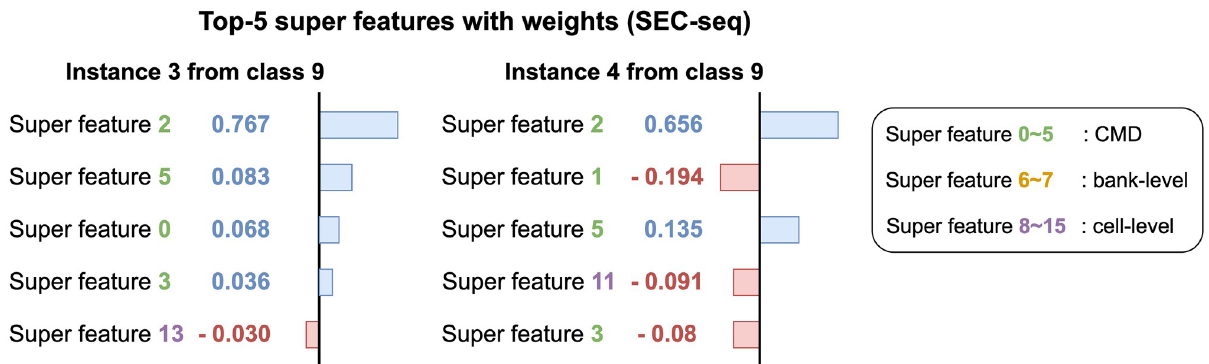
Fig 7. Interpretation of two instances for class 9 from SEC-seq dataset. Instance 3 is correctly classified but instance 4 is misclassified as class 8. Super feature 2 helps classify instances into class 9 while super features 1, 11, and 3 restrain the instance 4 from being classified into class 9.